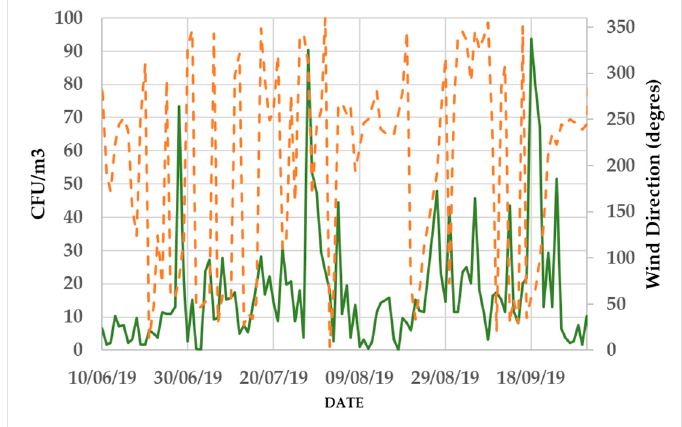
Figure A4. Variability of Wind direction in Degrees° (orange curve) and culturable bacterial concentrations in CFU/m 3 (green curve) from 10 June 2019 to 23 September 2019.